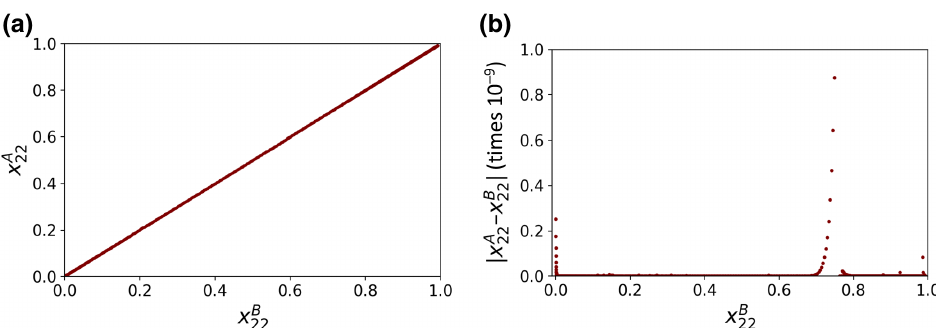
FIG. 2. (a) Plot of x B versus x A , where x A is predicted using the reconstructed density matrix. The linear plot shows that x A 22 22 22 for all values of x B . (b) Plot of the absolute difference between the predicted and true mean values x 22 . Absolute differences of the 22 order of 1 × 10 − 9 show that the reconstructed density matrix correctly predicts the value of x 22